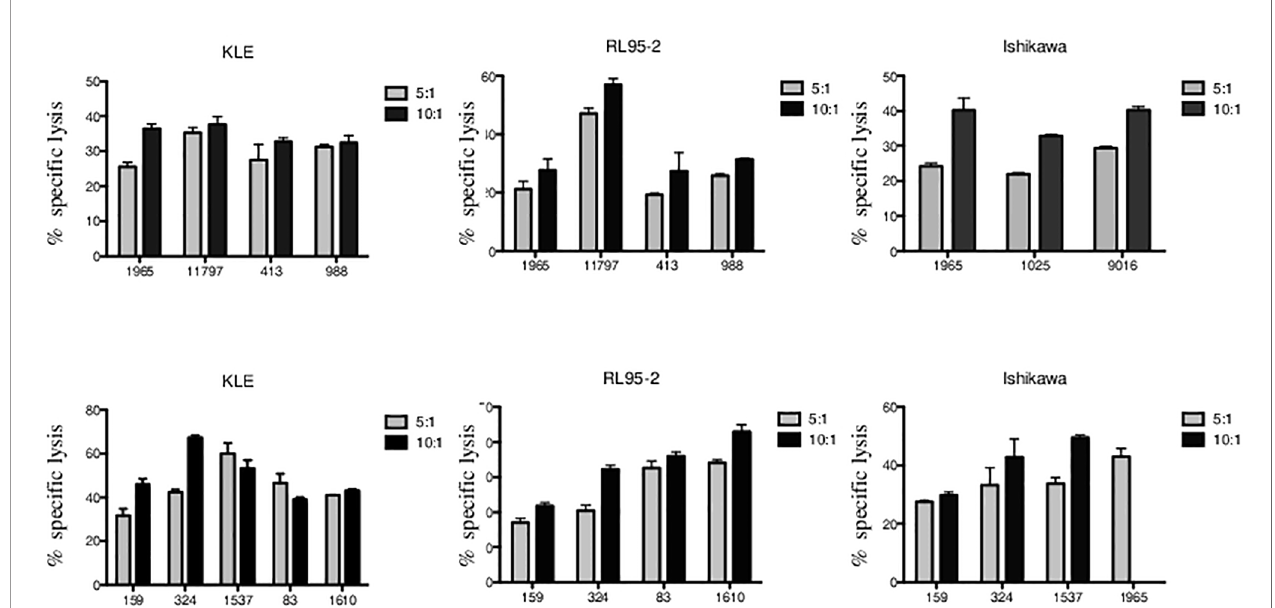
FIGURE 4 | V d 1 and V d 2 gd T-cell-mediated killing of endometrial tumor cell lines KLE, RL95-2, and Ishikawa. Freshly sorted gd T cells from three to fi ve healthy donors (numbered anonymously) were co-cultured with tumor targets for 4 h, and speci fi c lysis was determined at 5:1 and 10:1 E:T ratio. The results from independent experiments of V d 1 gd T-cell cytotoxic reactivity against KLE, RL-95, and Ishikawa is shown as the mean ± SD of sample duplicates. Summary data of speci fi c lysis and prominent cytotoxicity of V d 2 gd T cells against KLE, RL-95, and Ishikawa is shown as the mean ± SD of independent experiments performed in duplicates.